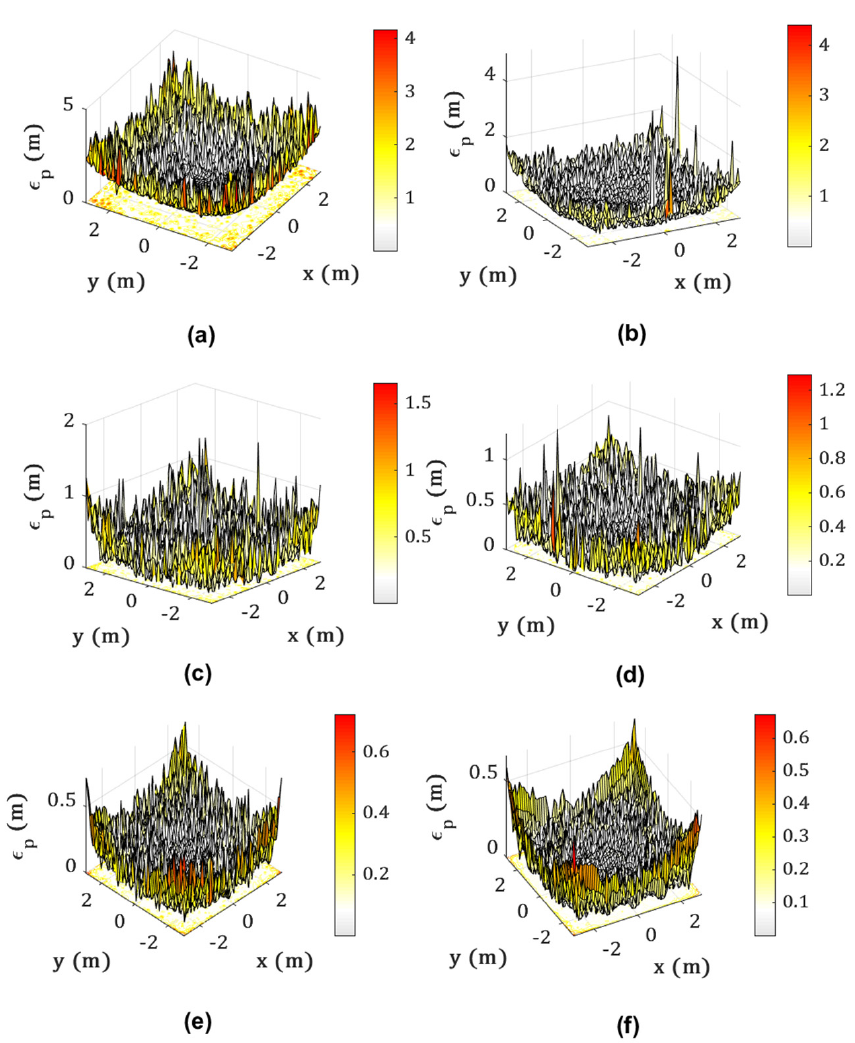
Figure 10. Different error distribution plots using BR algorithm for SNR value: ( a ) 5 dB; ( b ) 10 dB; ( c ) 15 dB; ( d ) 20 dB; ( e ) 25 dB; and ( f ) 30 dB. Table 5. Final observations of the comparison of BR and traditional RSS with NLLS algorithms.